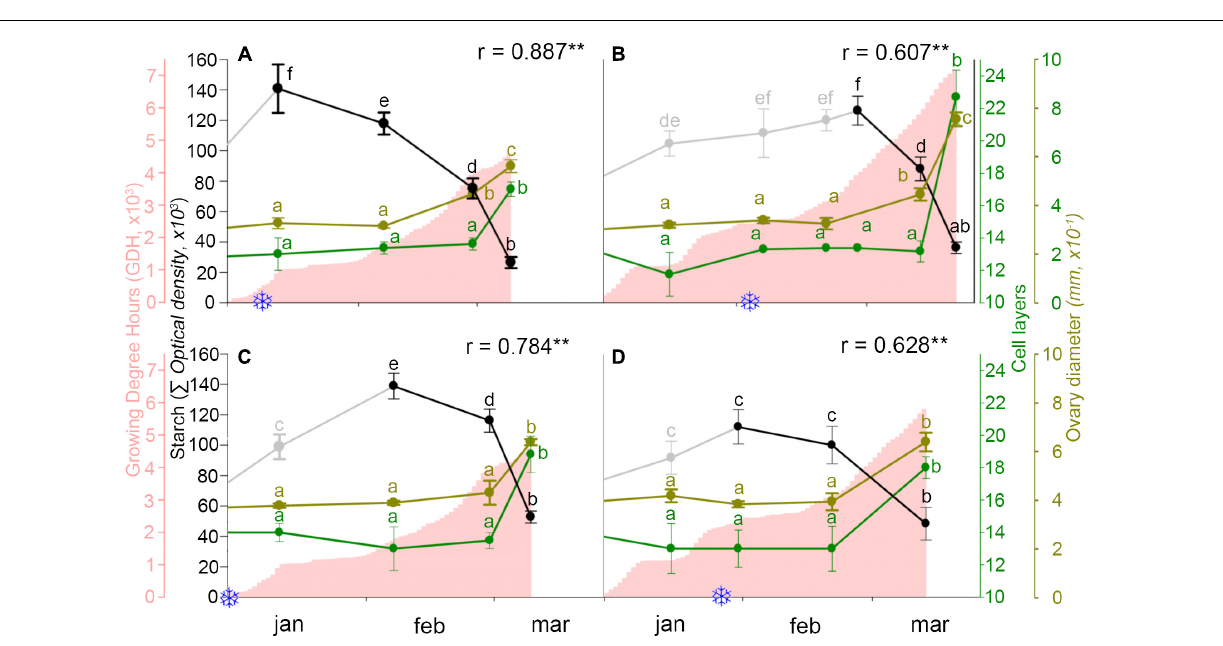
FIGURE 6 | Ovary starch content (gray/black line), heat accumulation (pink area), and ovary growth as number of cell layers of the ovary wall (green line) and ovary diameter (brown line), in two sweet cherry cultivars during 2 years. (A) ‘Bing,’ cold year. (B) ‘Bing,’ mild year. (C) ‘Burlat,’ cold year. (D) ‘Burlat,’ mild year. Snowflakes: dates of chilling fulfillment. r, Pearson’s correlation coefficients between the starch content and heat accumulation for each cultivar and year. ∗ P < 0.05; ∗∗ P < 0.01. Different letters (a–f) indicate significant differences ( P < 0.05) using the Duncan’s multiple-range